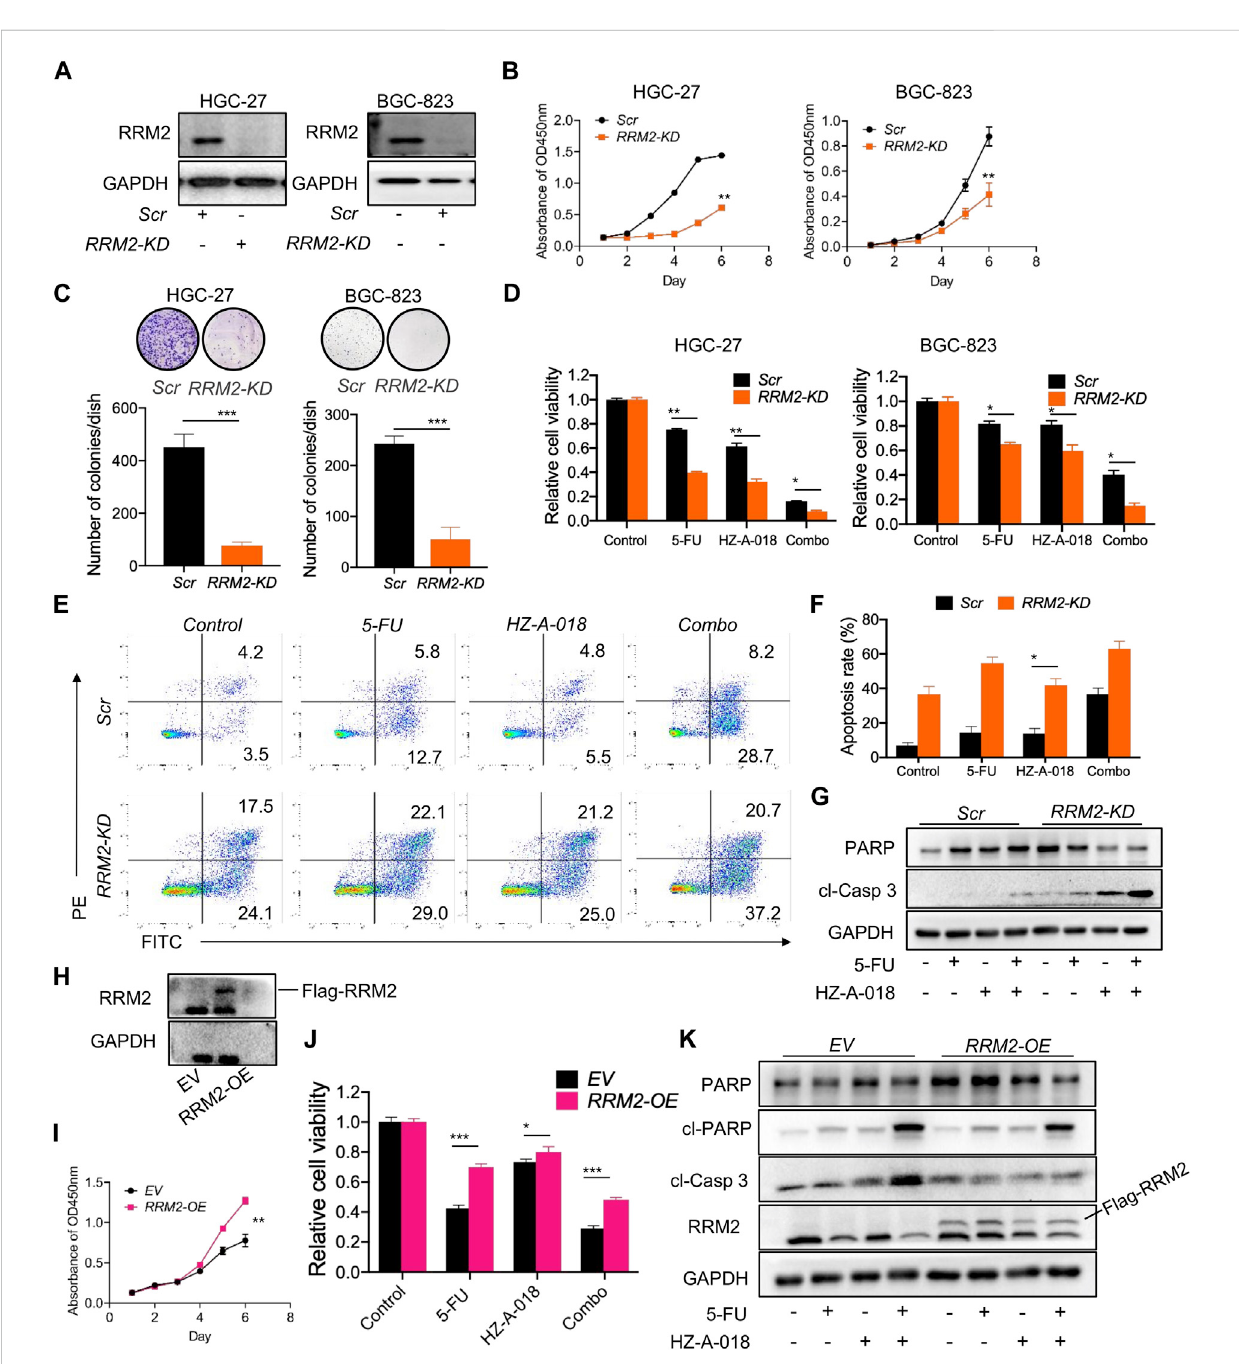
FIGURE 6 The expression of RRM2 in fl uenced biological phenotypes of gastric cancer cells. (A) The successful knockdown (KD) of RRM2 by using siRNA in HGC-27 and BGC-823 cells. (B) RRM2-KD signi fi cantly reduced the proliferation of both HGC-27 and BGC-823 cells comparing with scrambled (Scr) control indicated by CCK-8 assay. (C) RRM2-KD signi fi cantly prevented the colony formation of both HGC-27 and BGC-823 cells. (D) RRM2-KD signi fi cantly sensitized gastric cancer cells to the combined treatment of 5-FU and HZ-A-018 indicated by CCK-8 assay. (E) RRM2-KD signi fi cantly induced the apoptosis after combined treatment of 5-FU and HZ-A-018 in HGC-27 cells. (F) Quantitative analysis of (E). (G) RRM2-KD augmented the expression of cleaved-caspase 3 in HGC-27 cells. (H) Overexpression of RRM2 (RRM2-OE) via viral transfection was validated by Western blot. (I) RRM2- OE obviously accelerated the proliferation rate of HGC-27 cells. (J) RRM2-OE attenuated the anti-proliferation effects of combined treatment of 5-FU and HZ-A-018 in HGC-27 cells. (K) Western blots of apoptotic proteins after HGC-27 cells were transfected with empty vehicle (EV) and RRM2-OE. * p < 0.05, ** p < 0.01, *** p <